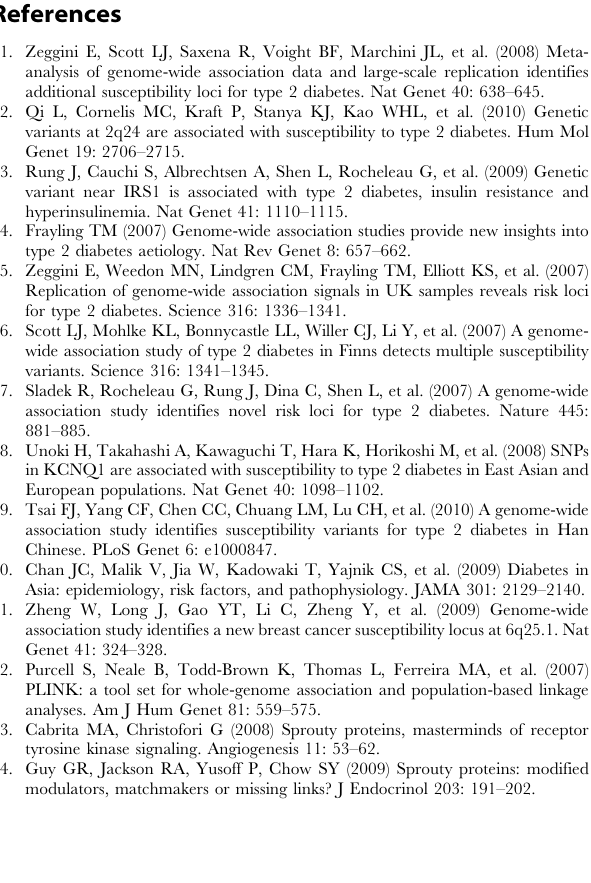
Table S4 Results for the four SNPs showing promising associations with T2D stratified by smoking, BMI, family history of type 2 diabetes, and age of diagnosis in the combined data.